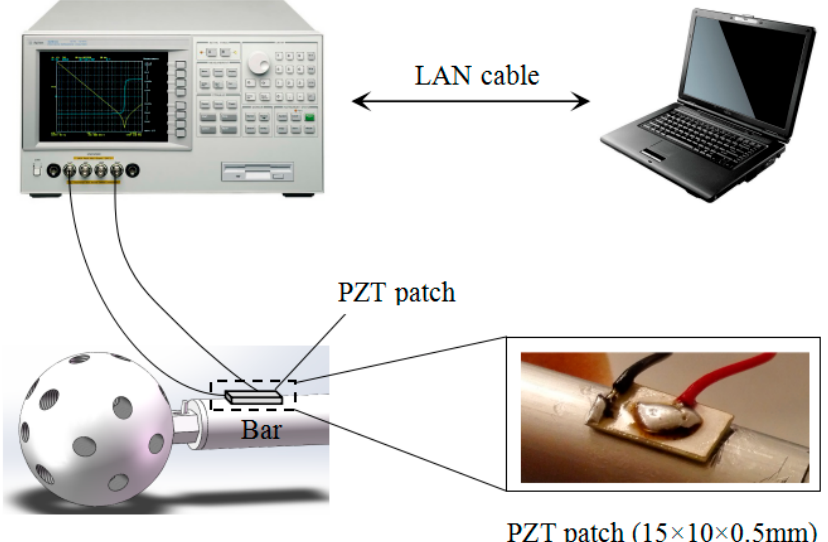
Figure 5. The schematic of bolt looseness monitoring inside the spherical joint based on EMI technique.